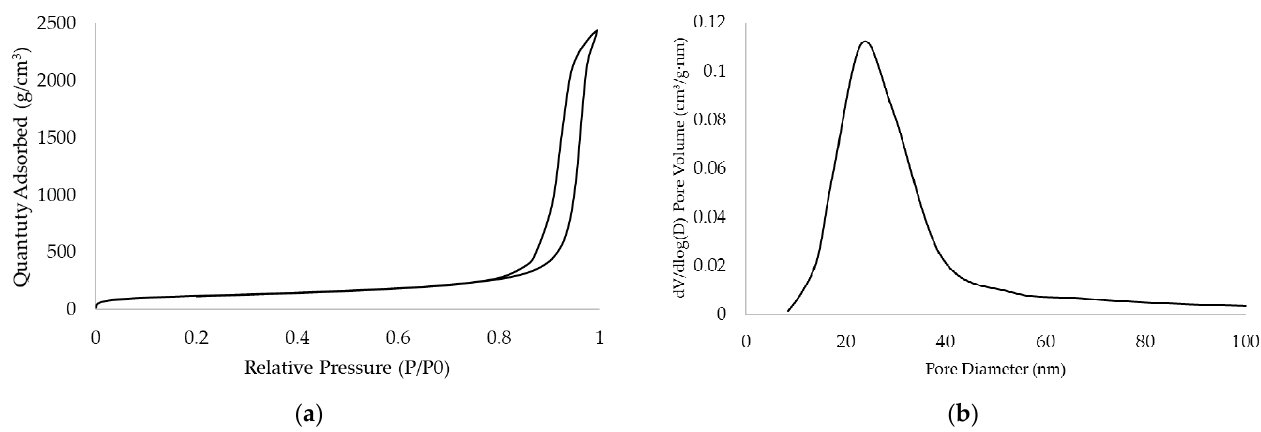
Figure 8. Adsorption–desorption isotherms are provided at 77 K in the alginate aerogel with complex geometry ( a ). Pore size distributions calculated using BJH method based on desorption isotherms of the alginate aerogel with complex geometry ( b